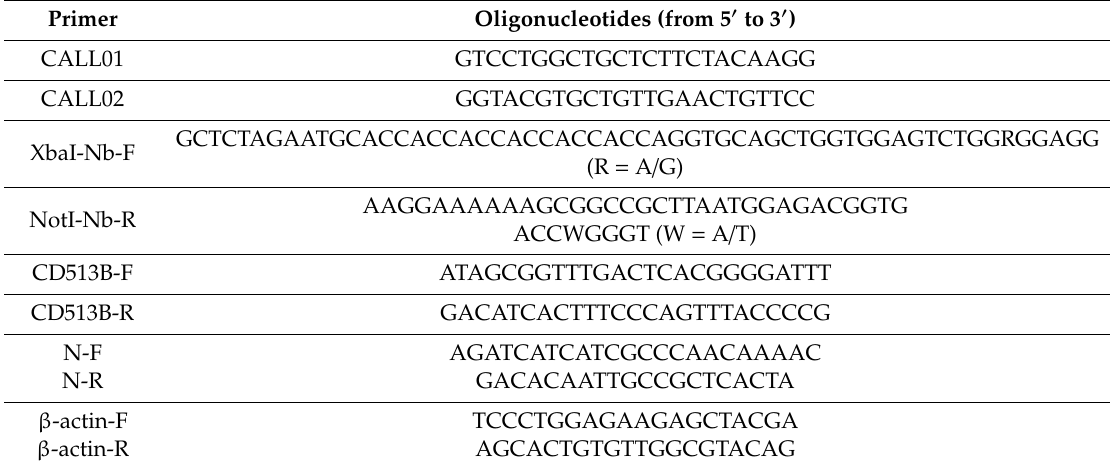
Table 1. Primers used in this